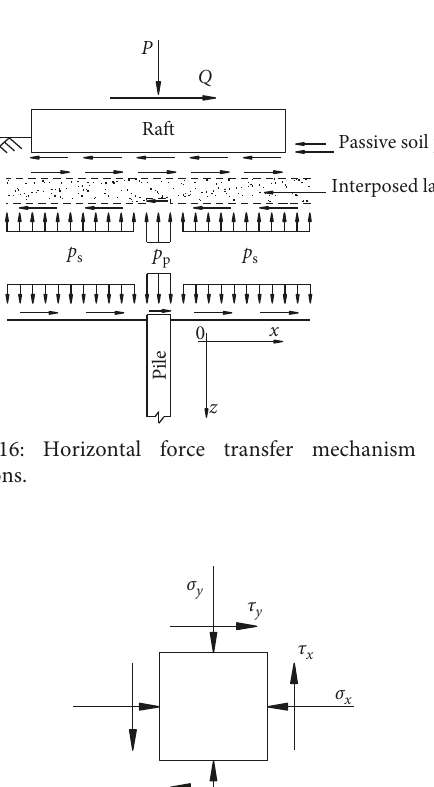
Figure 15: Soil shear band nephogram: horizontal load of (a) 100N and (b)